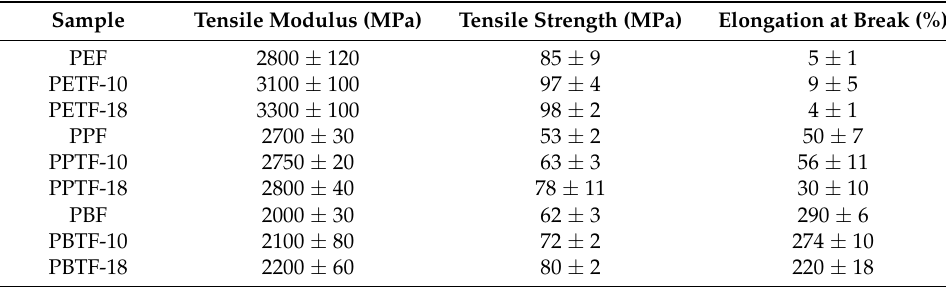
Table 3. Tensile properties of PEF, PPF, PBF, and the copolyesters modified with